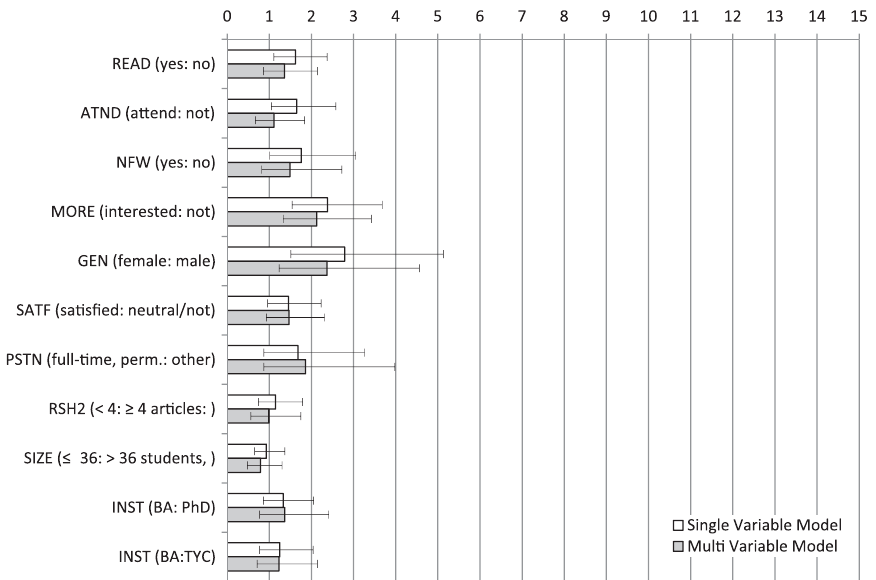
FIG. 4. Odds ratios and 95% confidence intervals for continued versus not-continued groups. A confidence interval that includes ‘‘1’’ suggests that the groups are not significantly different.